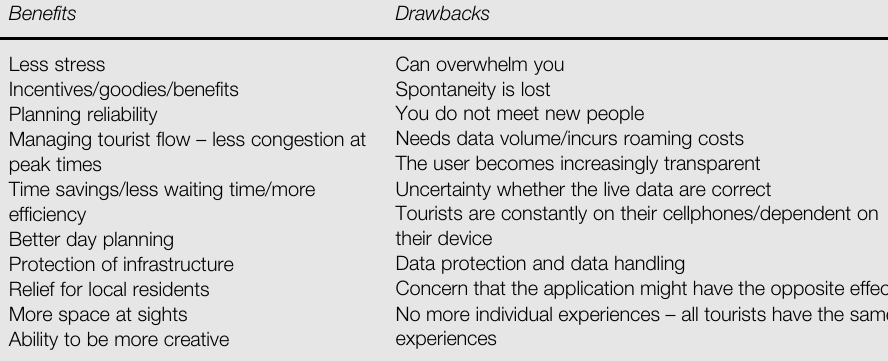
Table VIII Benefits and drawbacks of the possible application Benefits